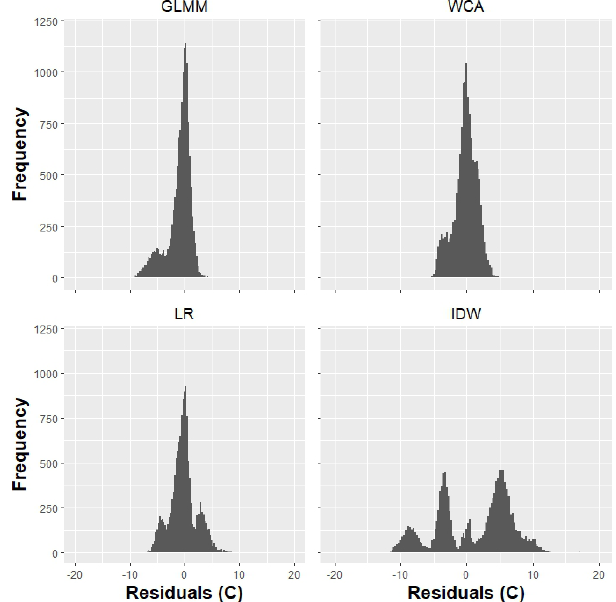
Figure 6. Residuals of the temperature LOOCV for each interpola- tion approach.